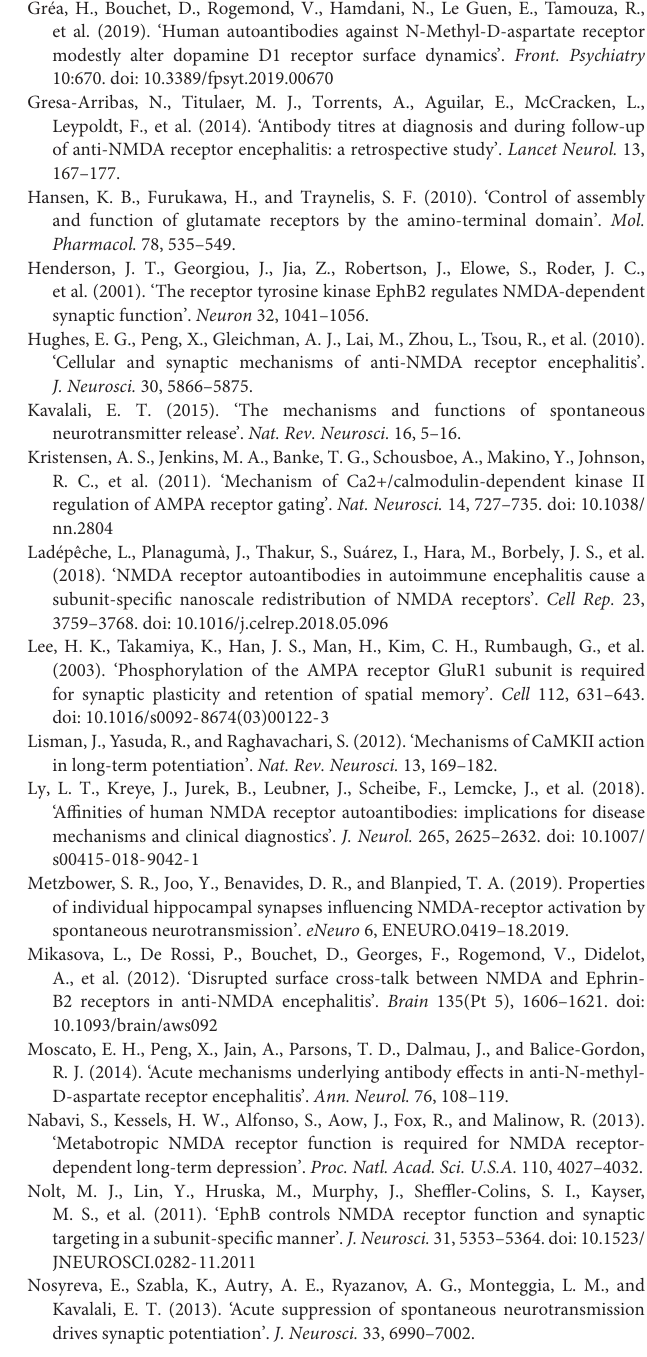
Supplementary Figure 2 | mSCaT amplitude and frequency analyses on per cell basis. (A) Dot plots of normalized mSCaT amplitude in individual treatments over time per cell. Vehicle or mAb added after 5 min